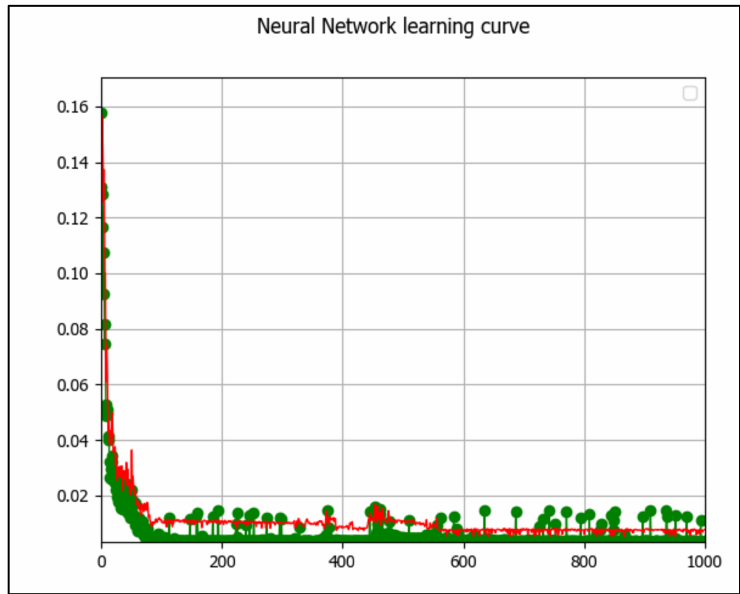
Figure 7. Neural network learning